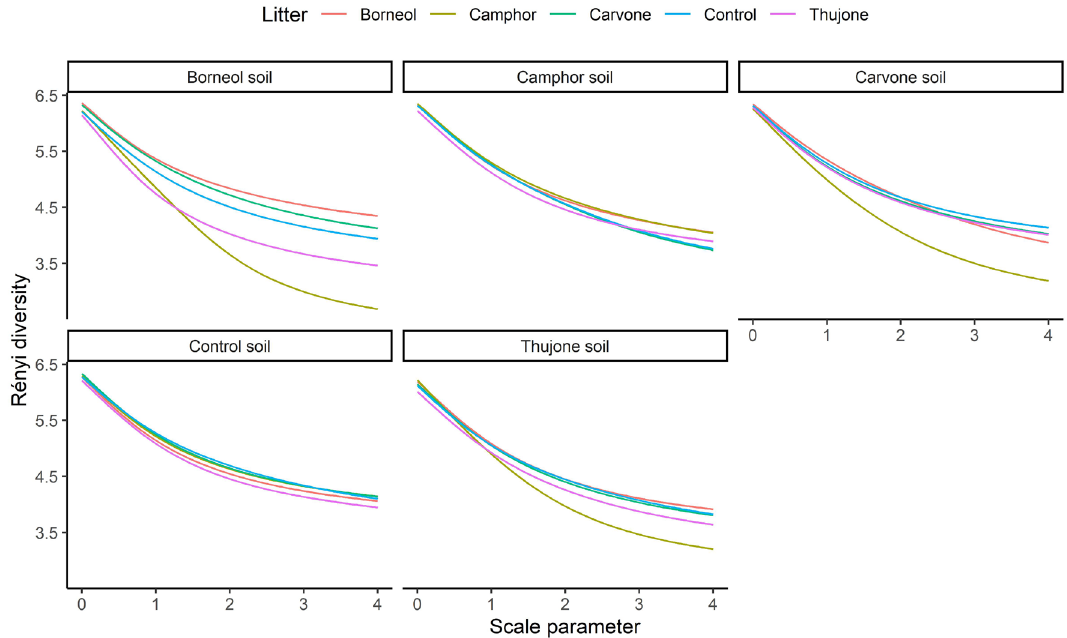
Figure 3. Diversity orders according to alpha diversity profiles of bacterial communities under different tansy chemotypes with own soil and with other chemotypes soil and control (no tansy).